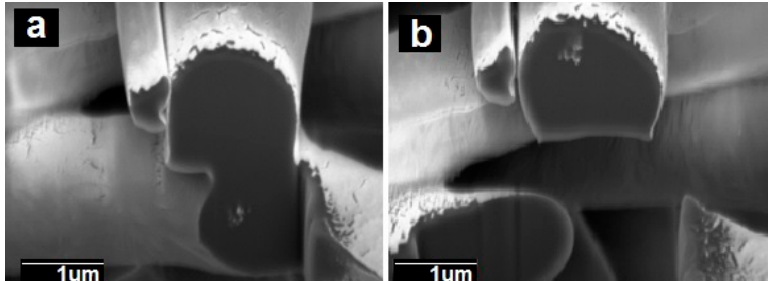
Figure 2. The cross-sectional SEM image of two PCL fibers with Pd nanoparticles after (FIB-SEM) sectioning. ( a ) PCL fiber 1 at the bottom with visible bright nanoparticles and ( b ) PCL fiber 2 at the top of the image with visible bright nanoparticles.